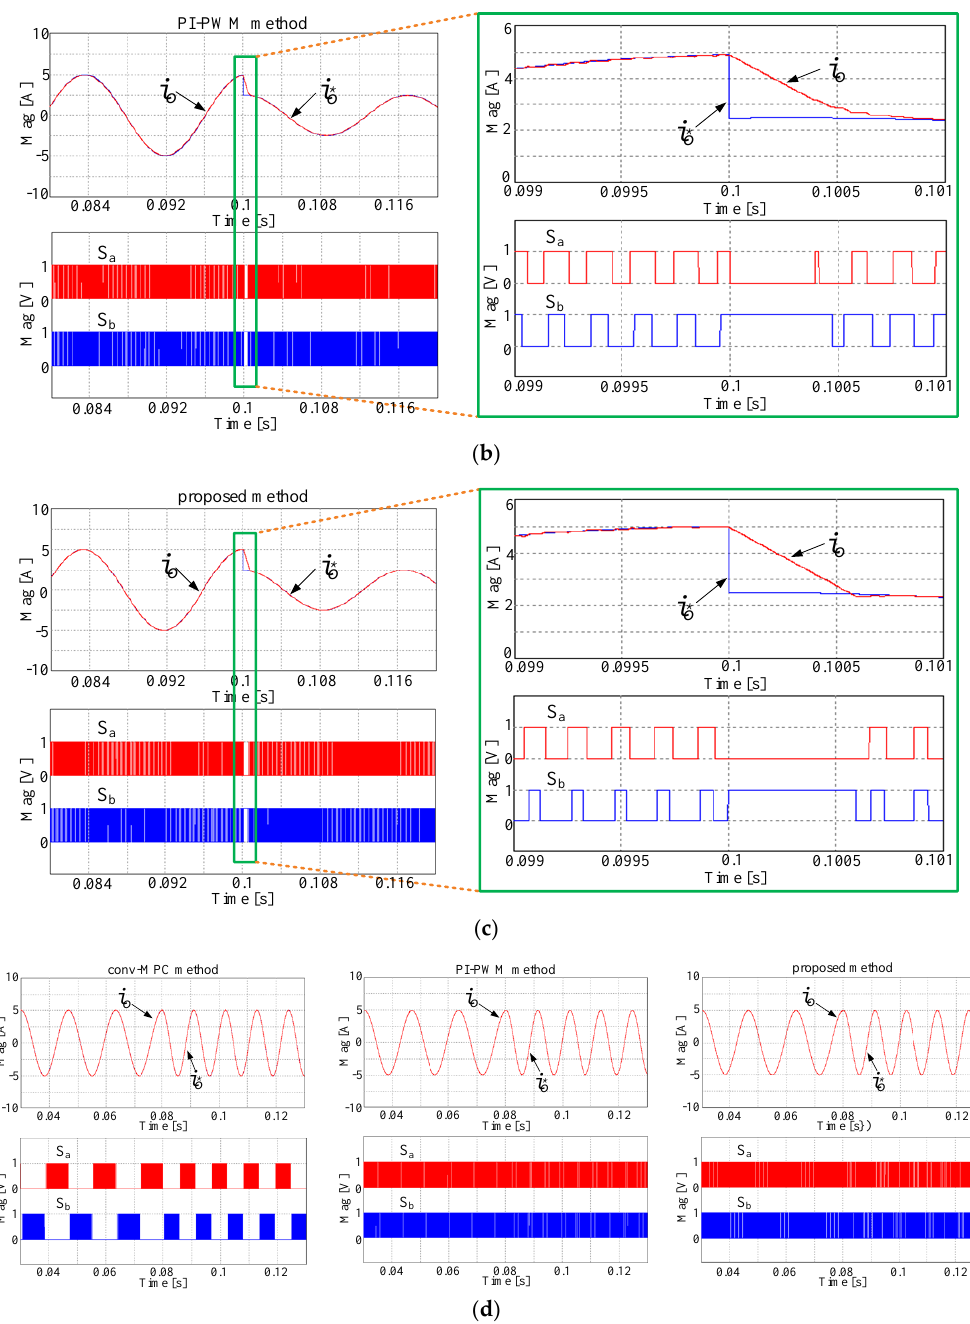
Figure 9. Simulation results of output current ( i o ), reference current ( i o * ), and upper switching states ( S a , S b ) used by ( a ) conv-MPC ( T s = 33 μs) with magnitude change (5 A → 2.5 A); ( b ) PI-PWM ( T sw = 200 μs) with magnitude change (5 A → 2.5 A); ( c ) proposed method ( T s = 200 μs) with magnitude change (5 A → 2.5 A); ( d ) three methods with frequency change (60 Hz → 90 Hz). methods in terms of total harmonic distortion (THD) and current errors, as a function of the switching frequency. For fair comparison, the average switching frequency of the conv-MPC method with varying switching frequency was equally set to the switching frequency of the PI-PWM and proposed